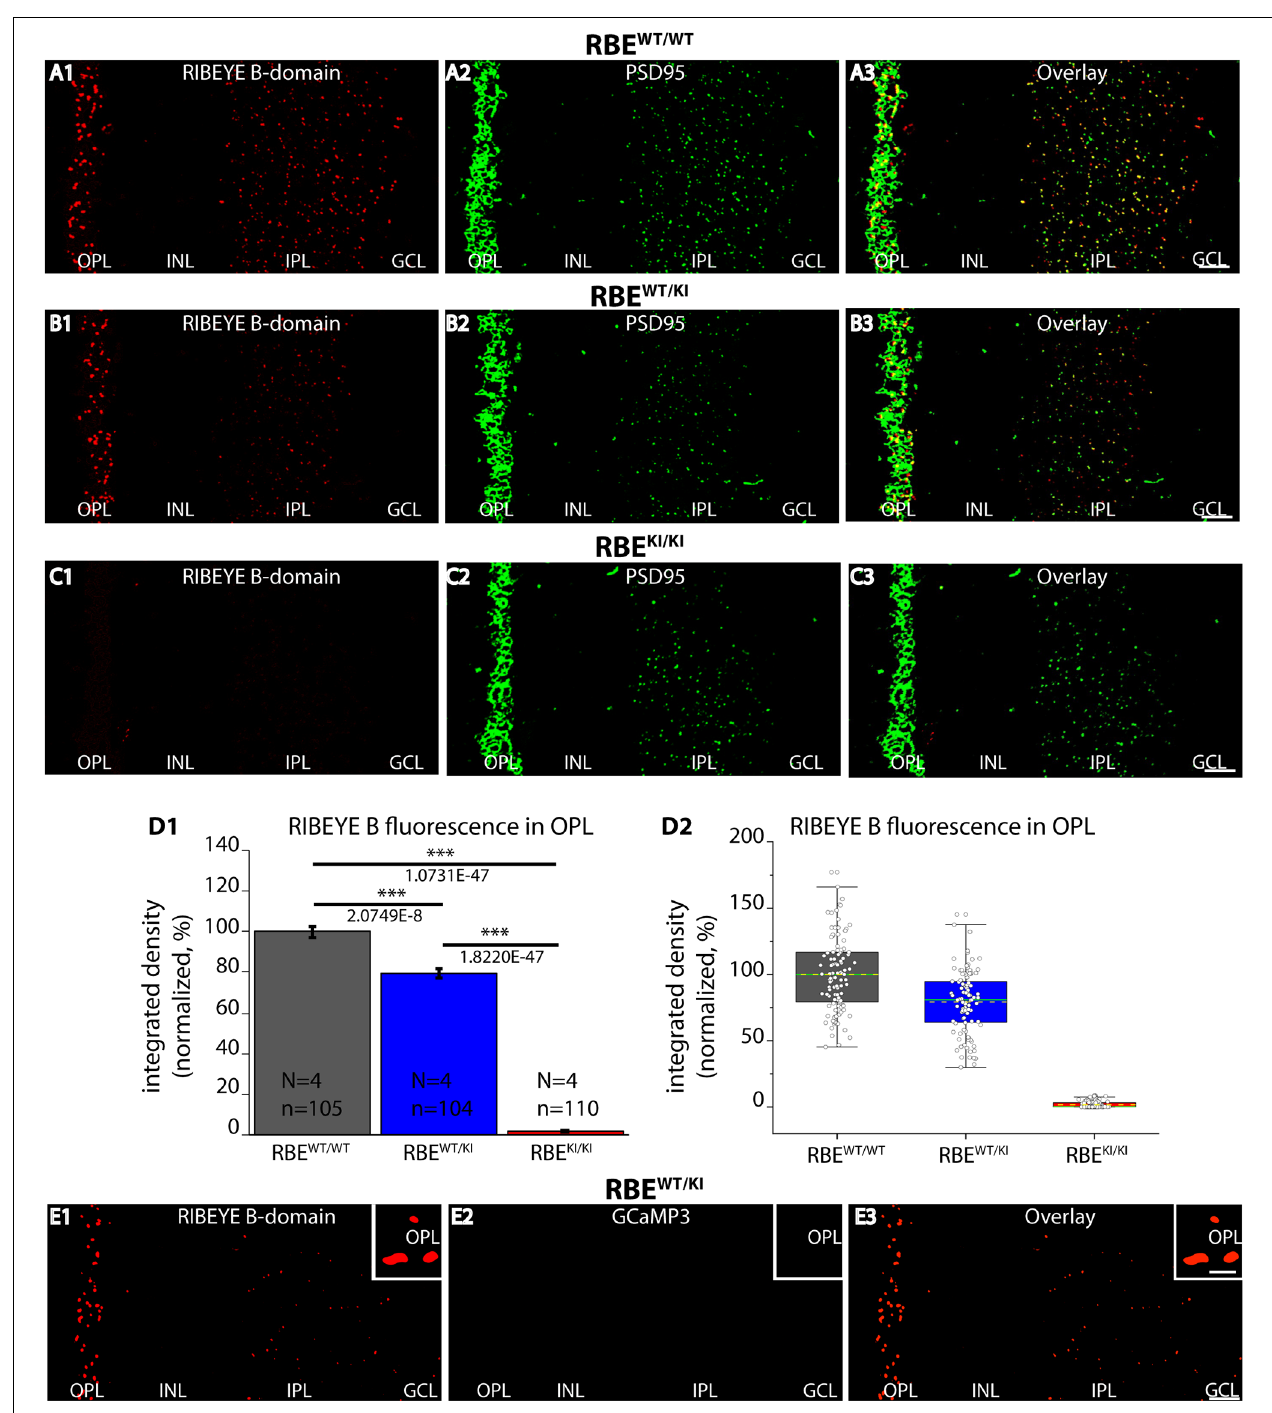
FIGURE 2 | RIBEYE B-domain immunosignals are absent in photoreceptor synapses of RBE KI/KI mice. (A1–A3,B1–B3,C1–C3) 0.5 µ m-thin retina sections from the indicated littermate mice (RBE WT/WT , RBE WT/KI , and RBE KI/KI ) were double-immunolabeled with mouse monoclonal anti RIBEYE B-domain (2D9) and rabbit polyclonal antibody against PSD95 (L667). (C1) RIBEYE B-domain immunosignals were completely absent in the OPL and IPL of RBE KI/KI mice. (D1) Quantification of RIBEYE B-domain immunofluorescence signals in the OPL (as integrated density). Quantification confirmed the absence of RIBEYE B-domain immunosignals in the OPL of RBE KI/KI mice. RIBEYE B-domain immunosignals in the OPL of RBE WT/KI mice were reduced in comparison to RBE WT/WT wild-type mice. Bar graphs show means ± S.E.M ( ∗∗∗ p ≤ 0.001). In the box and whisker plots (D2) of the data from (D1) , mean values are labeled by horizontal dotted yellow lines and median values by horizontal solid green lines. The boxes represent 25th-75th percentiles, and whiskers 1.5 times IQR. The statistical analysis was performed by Student’s t -test (for